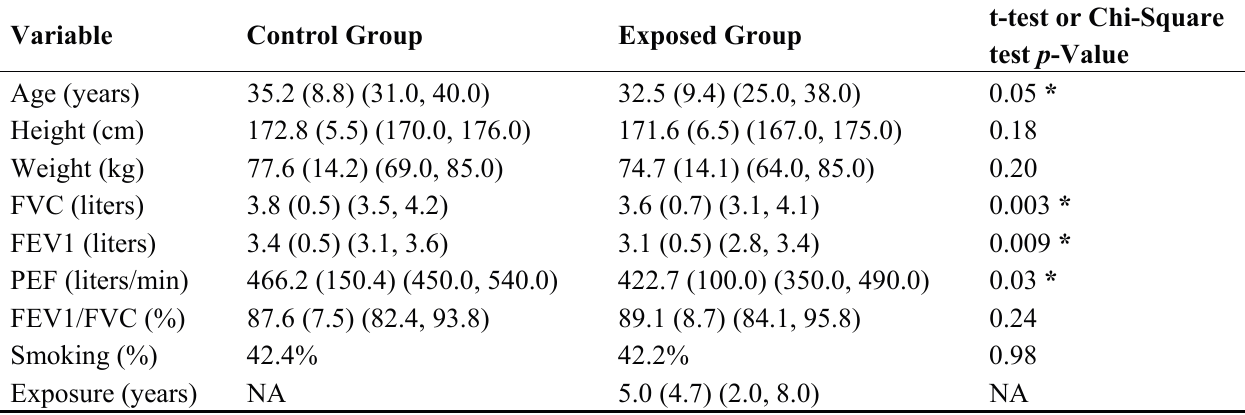
Table 1. Summary measures of control and exposed groups. Mean (Standard deviation) (25th percentile, 75th